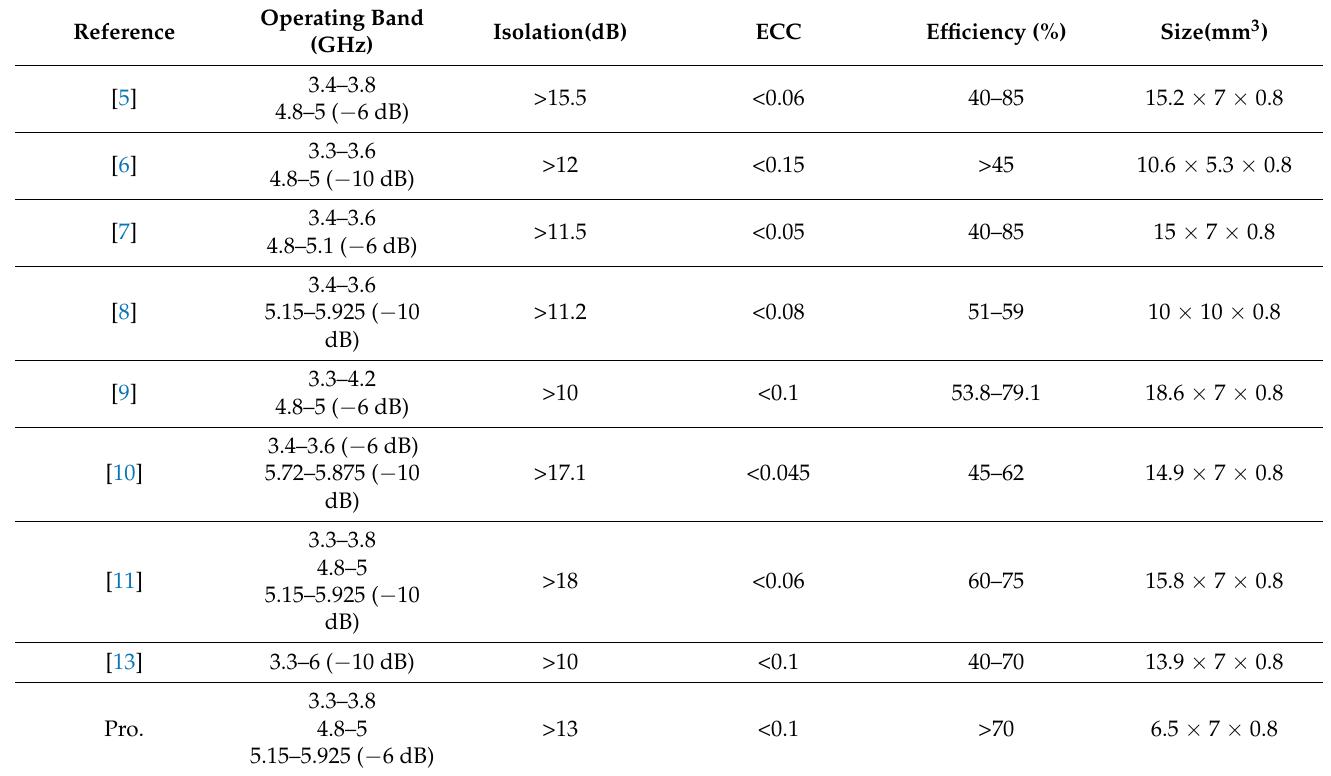
Table 1. Comparison of the 5G MIMO smartphone